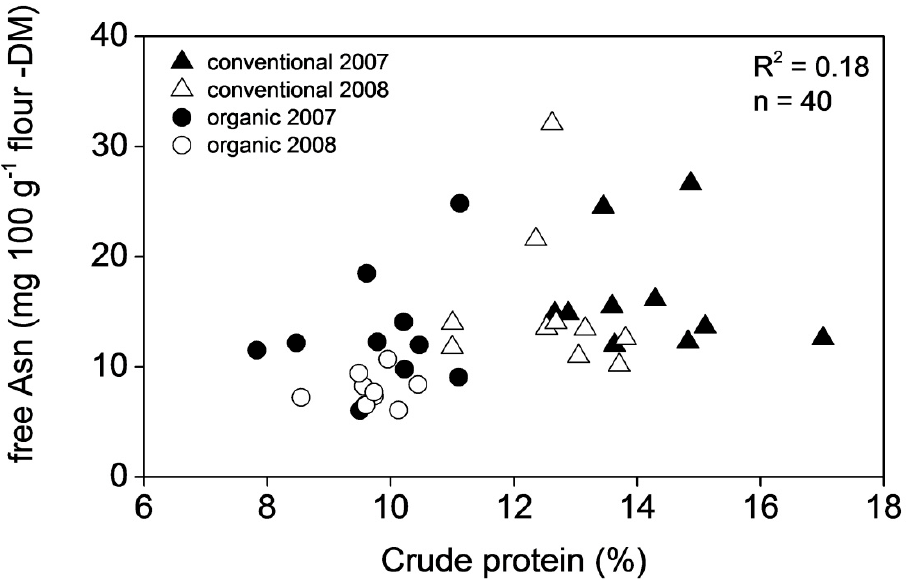
Figure 2. Relationship between crude protein content and free Asn levels in wheat flours produced under conventional and organic conditions in 2007 and 2008.